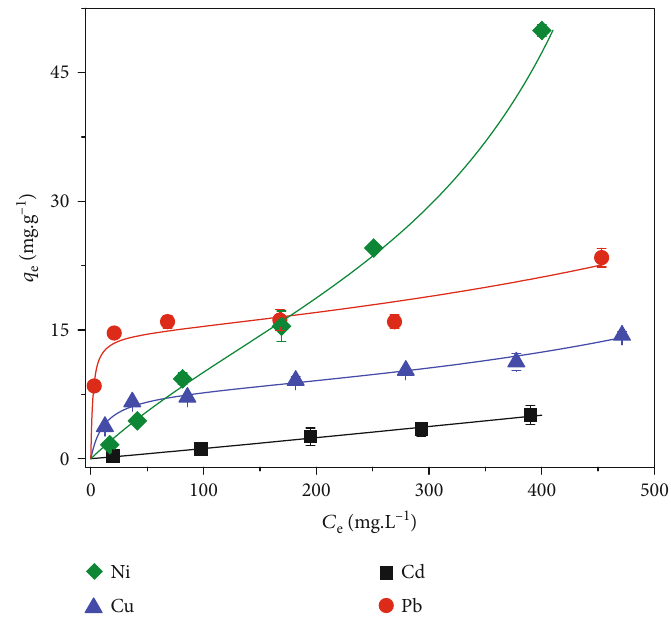
Figure 6: Adsorption isotherms in single-metal solutions. Table 3: Fit parameters for the isotherm models and maximum uptake by Schi ff base-modi fi ed aerogel-like